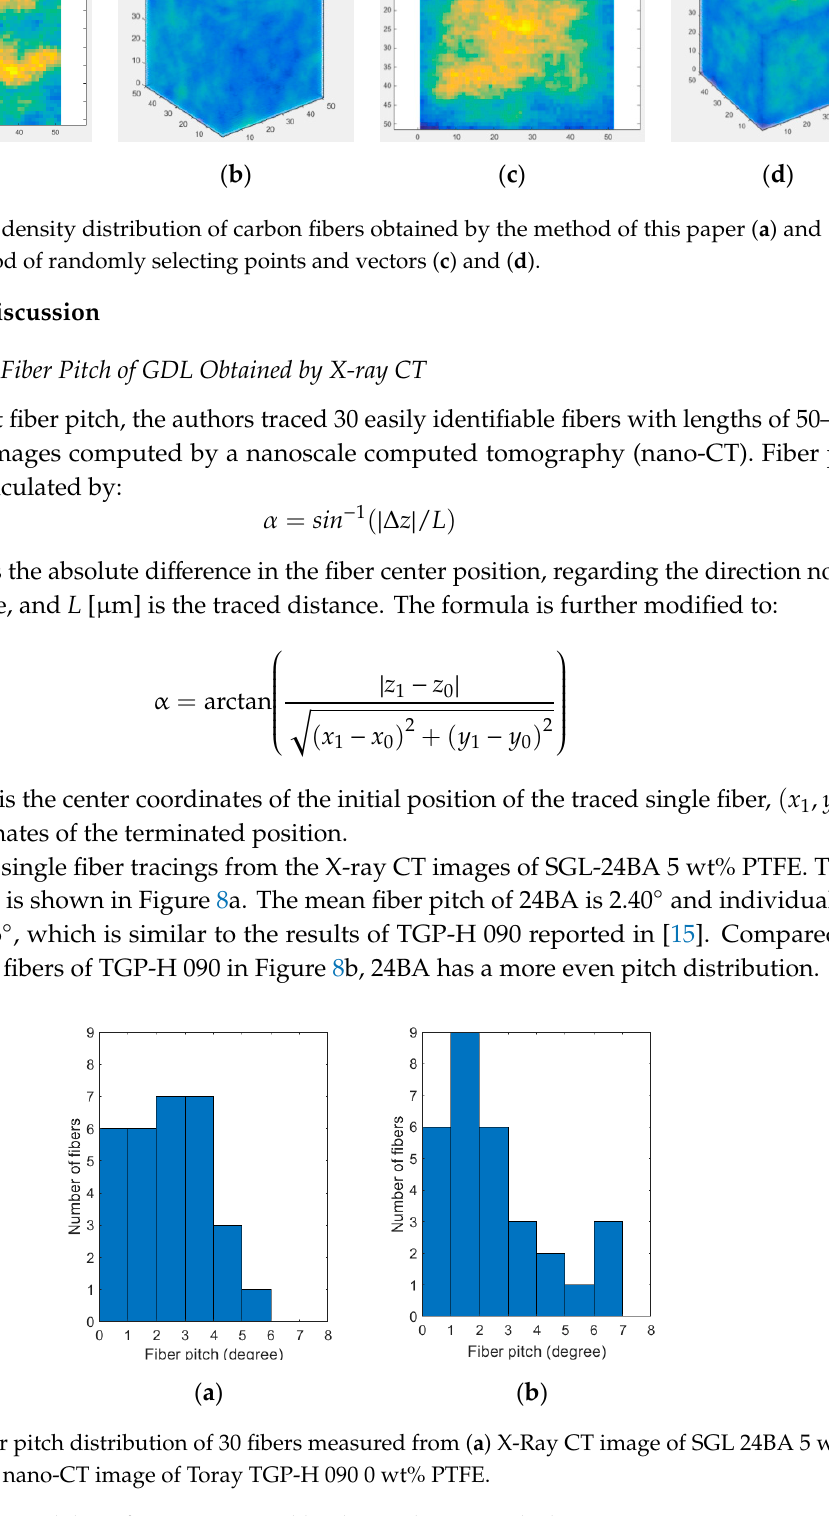
PTFE; and ( b ) nano-CT image of Toray TGP-H 090 0 wt% PTFE.